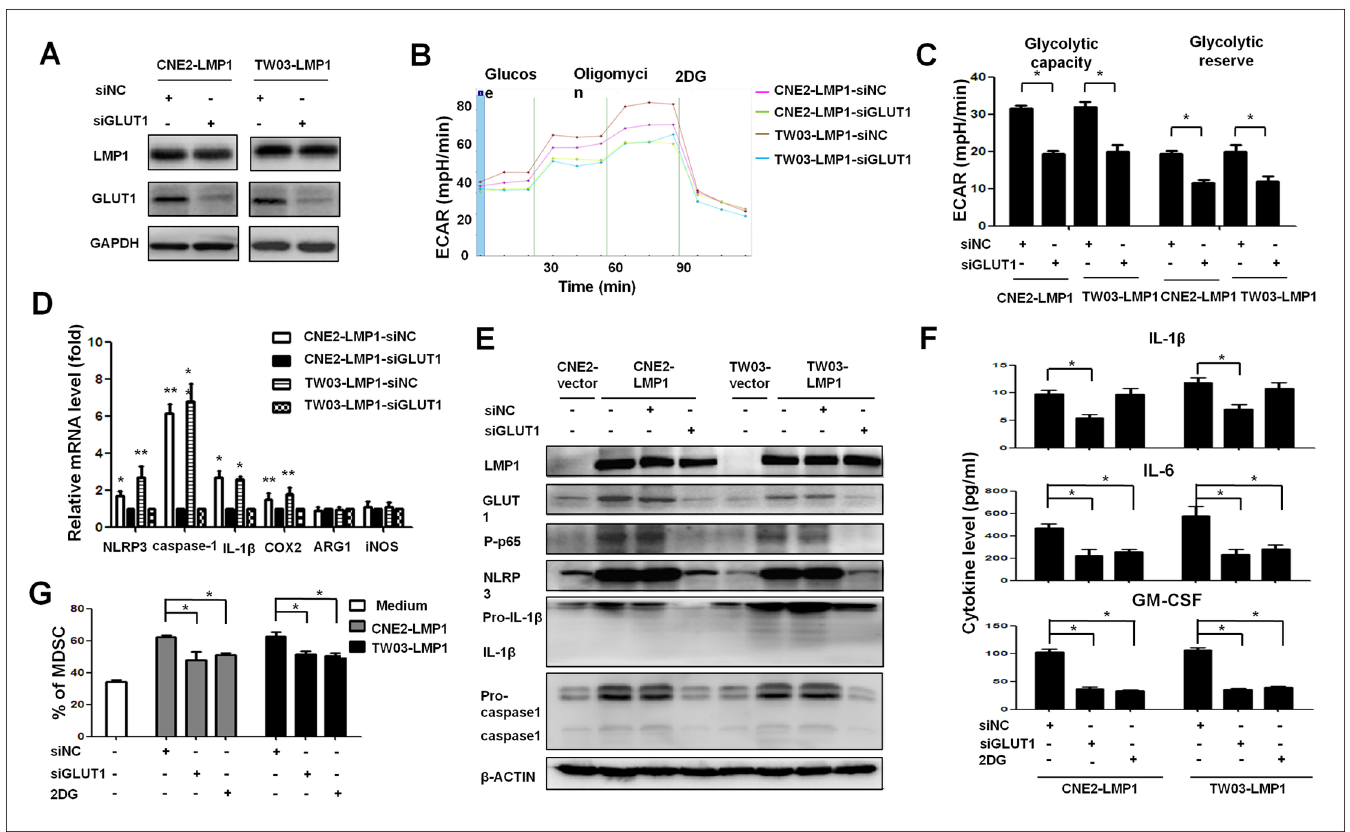
Fig 4. GLUT1-dependent glycolysis was required for NPC-LMP1-mediated MDSC differentiation. ( A ) WB showedthe level of GLUT1 in CNE2-LMP1-siNC, CNE2-LMP1-siGLUT1, TW03-LMP1-siNCand TW03-LMP1-siGLUT1 cells, and GAPD was includedas the control. ( B and C ) Representative ECAR assays for CNE2-LMP1-siNC, CNE2-LMP1-siGLUT1, TW03-LMP1-siControland TW03-LMP1-siGLUT1 cells. The time course and calculations for ( B ) glycolytic capacity and ( C ) statistical analysisof glycolyticcapacity and glycolytic reserve are shown. ( D ) Expression of the NLRP3, ASC, caspase-1,IL-1 β , COX-2, Arg-1 and iNOS mRNAs was determinedvia qRT-PCR in CNE2-LMP1-siControl, CNE2-LMP1-siGLUT1, TW03-LMP1-siControl and TW03-LMP1-siGLUT1 cells. ( E ) Representative immunoblotting of NPC-vector, NPC-LMP1, NPC-LMP1-siNC and NPC-LMP1-siGLUT1 cells stained with the indicatedantibodies (n = 5). ( F ) Secretion of the cytokines IL-1 β , IL-6 and GM-CSF from NPC-LMP1 cells followingtreatment with siGLUT1, siControl(siNC) or 2-DG was determined via ELISA. ( G ) Statistical analysisof the percentageof CD33 + CD11b + HLA-DR - MDSCs mediatedby CNE2-LMP1 or TW03-LMP1 cells followingtreatment with siGULT1, siNC or 2-DG. Data are presented as the means ± SEM of representative experiments performed in triplicate. * P < 0.05, ** P < 0.01 comparedwith the control treatment.